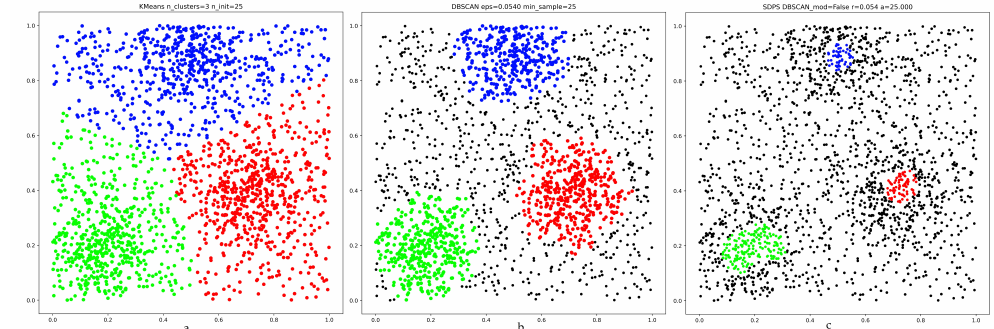
Figure 7. Comparison of the results of the algorithms. ( a ) Results of clustering with the k-means algorithm. ( b ) SDPS algorithm. ( c ) DBSCAN